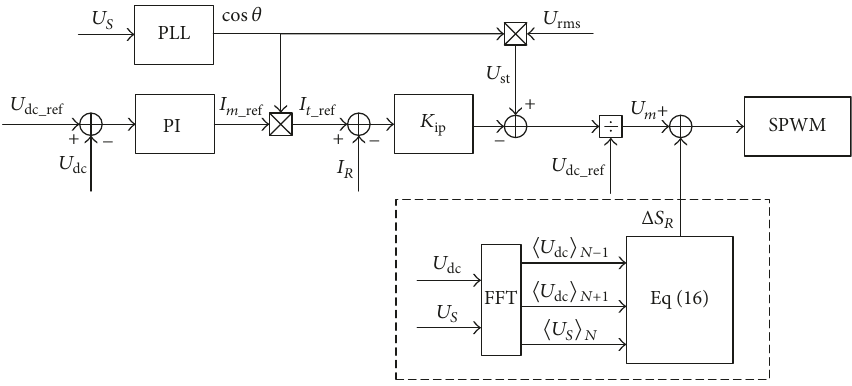
Figure 4: Control block diagram of injected 𝑁 -order modulation wave.